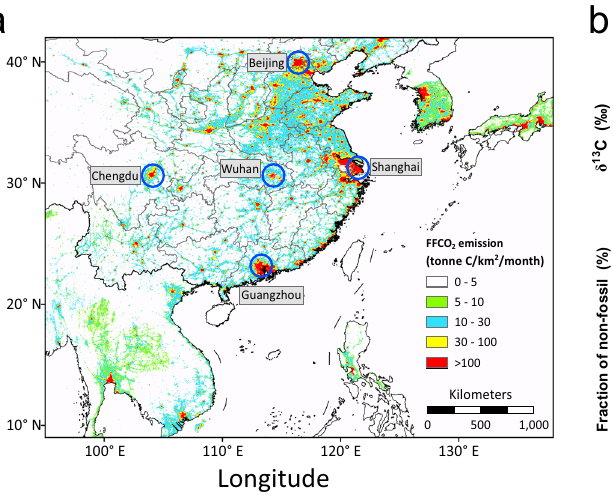
naturalearthdata.com/). The administration boundaries in the map are originated from map products of National Geomatics Center of China (https://www.webmap. cn/). b The difference of δ 13 C and 14 C-based fraction of non-fossil sources between oxalic acid and WSOC in winter (January 2018) and in summer (July 2018), respectively. The error bars for δ 13 C composition represent the relative standard deviation for repeat analyses (n=3). The error bars for 14 C-based fraction of non- fossil sources represent ±1 standard deviation for total propagated uncertainty (Supplementary Method